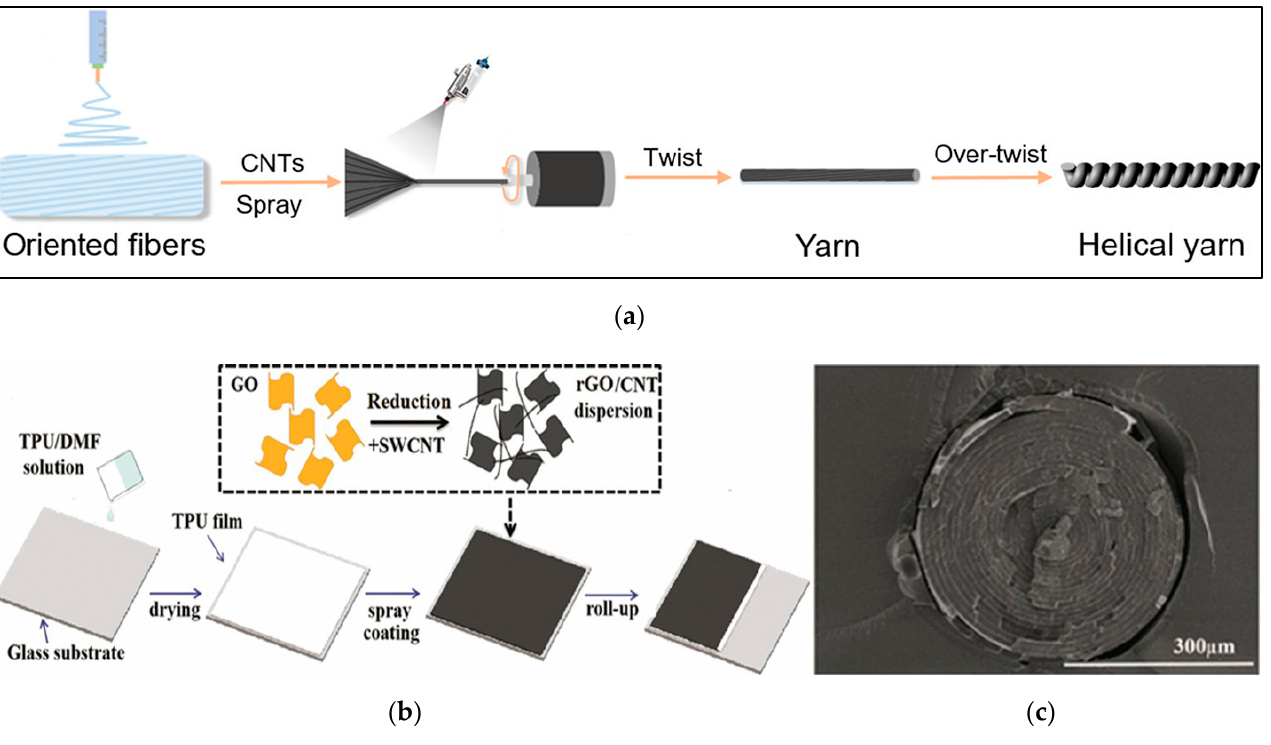
Figure 10. ( a ) Schematic diagram of the preparation of helical CNT/PU yarn [99] ( b ) Schematic diagram of the preparation of SWCNT-RGO/TPU strain sensor ( c ) SEM image of spiral layered SWCNT-RGO/TPU yarn [100].